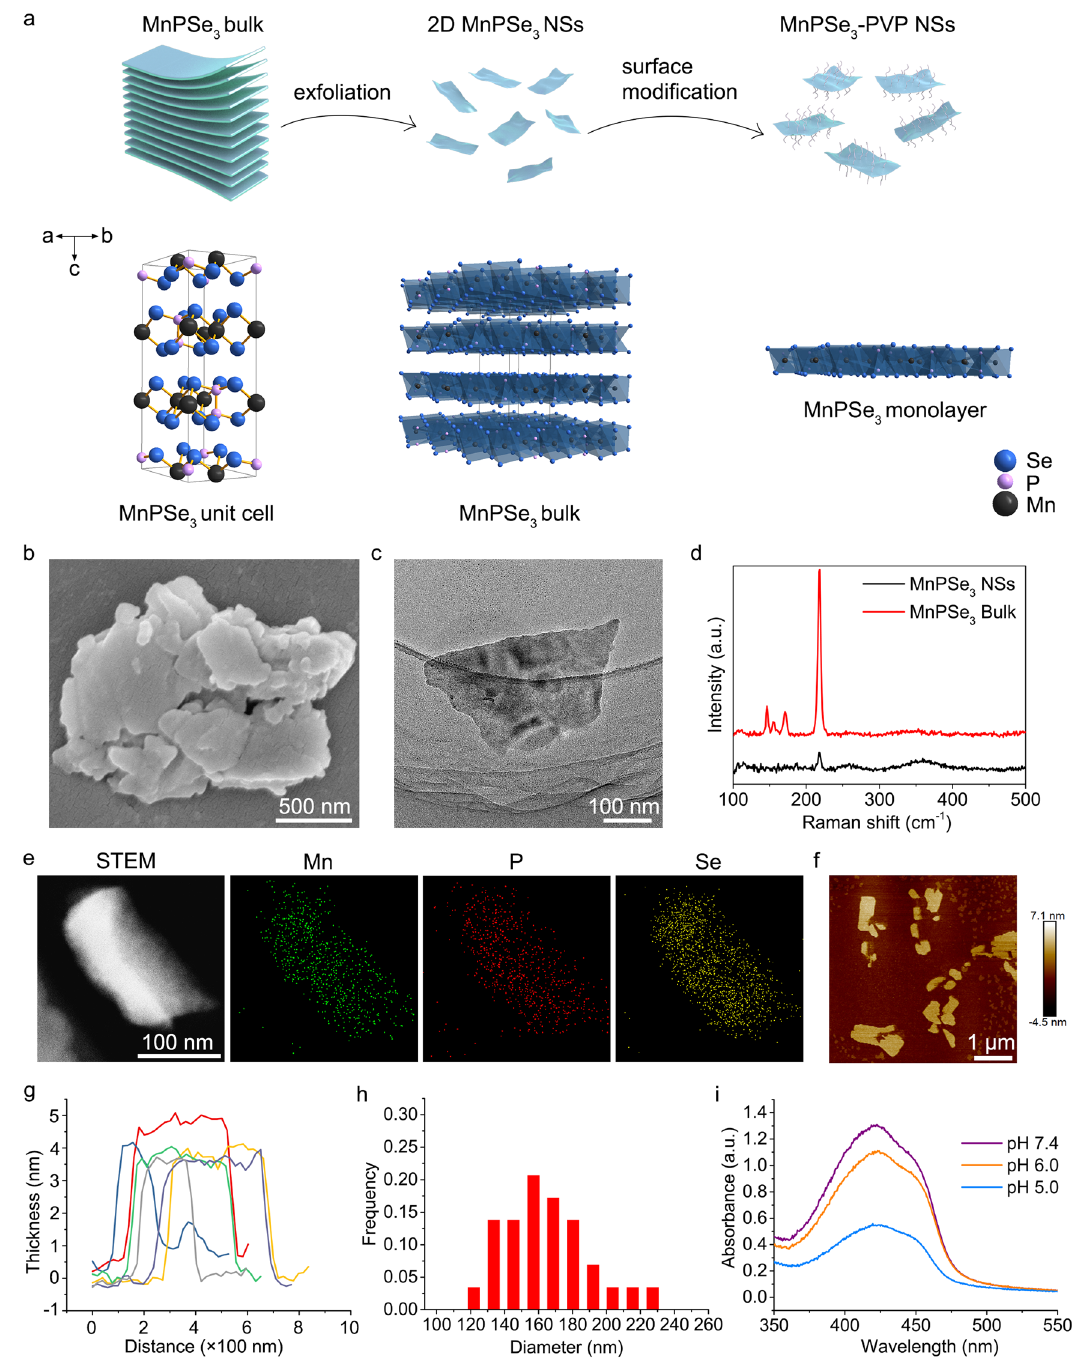
Fig. 2 | MPS preparation and characterization. a Schematic illustrations of the synthesis of MPS and its molecular structure. b SEM image of bulk MPS. Scale bar, 500nm. c TEM imageof MPSNSs.Scalebar,100nm. d Ramanspectraof bulkMPS and MPS NSs. e Elemental mapping of MPS NSs. Scale bar, 100nm. f Typical AFM